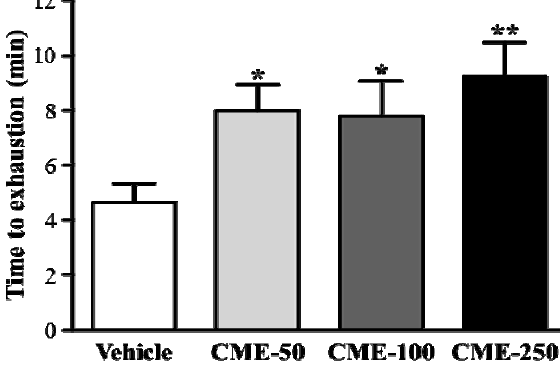
Figure 3. Effect of CME supplementation on swimming exercise performance. Mice were pretreated with vehicle, 50, 100, and 250 mg/kg of CME for 14 days and, then 1 h later performed an exhaustive swimming exercise with a 5% body-weight load attached to the mouse tail. Data represent mean ± SEM (n = 8 mice). * p < 0.05; ** p < 0.01 compared to vehicle